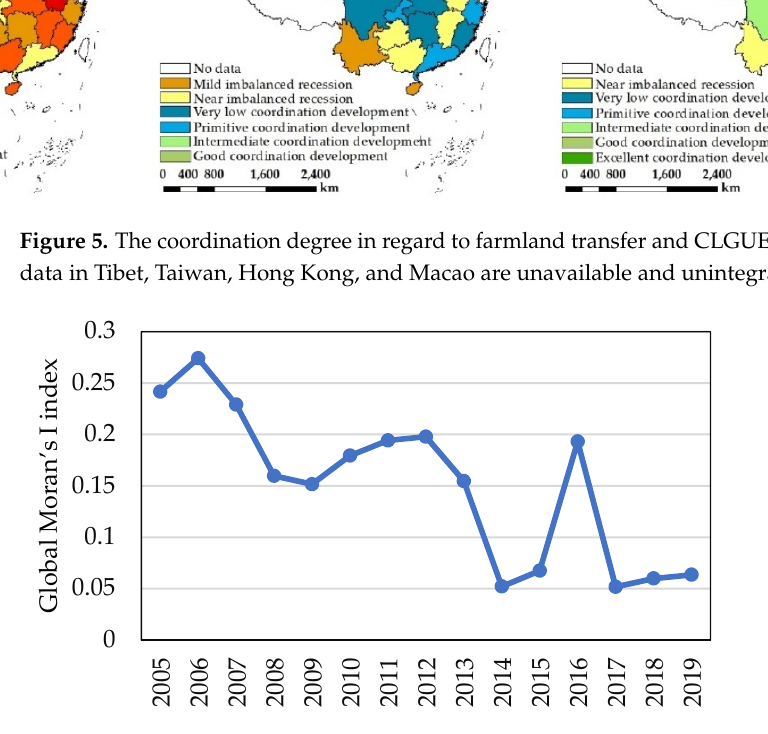
Figure 6. Global Moran’s I index of the coordination degree concerning farmland transfer and CLGUE in China.